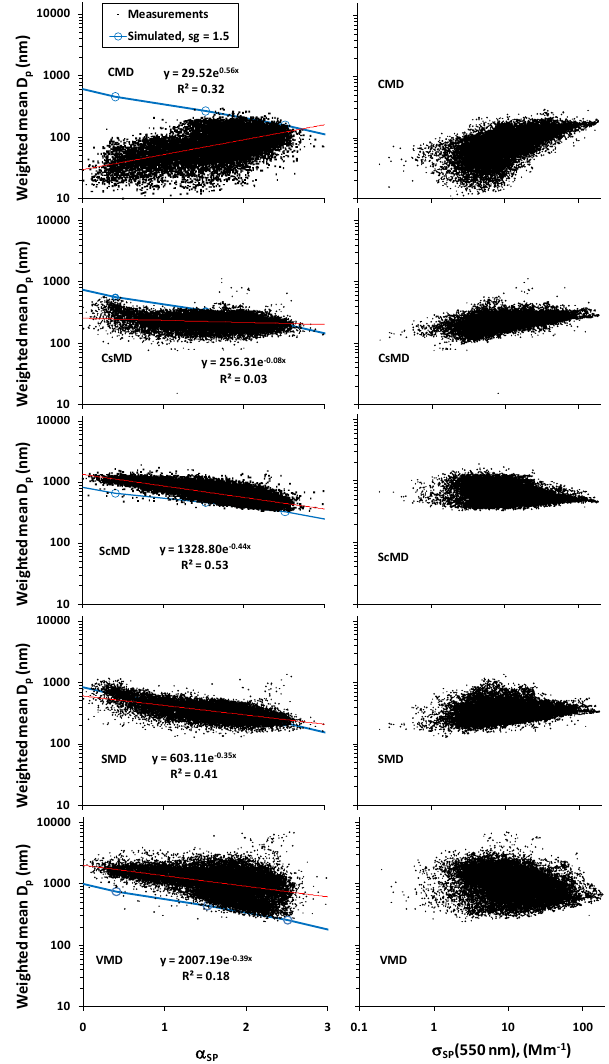
Fig. 13. Weighted mean diameters ( D p < 10µm) as a function of α SP and σ SP . The red lines are exponential curves D p 0 exp( − k · α SP ) fitted to the data and the blue lines respective weighted mean diameters calculated from simulated lognormal size distributions, see text for